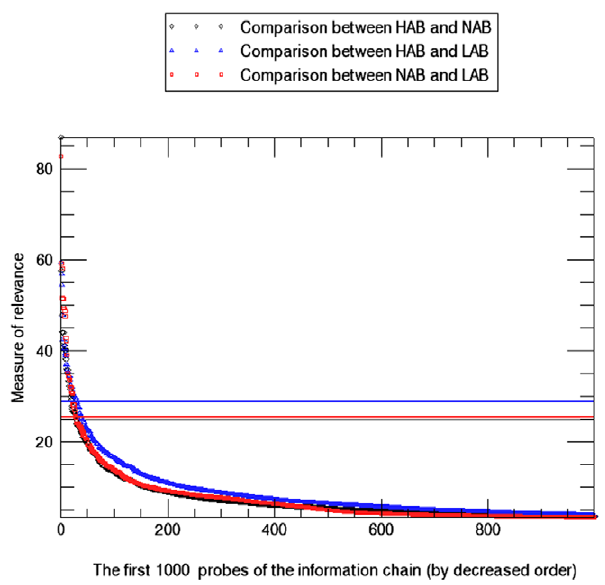
Figure 5. Measure of relevance for gene expression data. Application of the MoR approach to molecular biological data (SNPs) for identifying SNPs with relevant differences in the allele frequencies between controls and patients with panic disorder. In each group the SNP-data of n ~ 50 subjects were examined. For the two-independent- sample problem on hand with binary data the MoR-values of three SNPs onthe chromosomes 10 , 11 and 12 showed MoR-values above thesample- related cut-off criterion ( d j